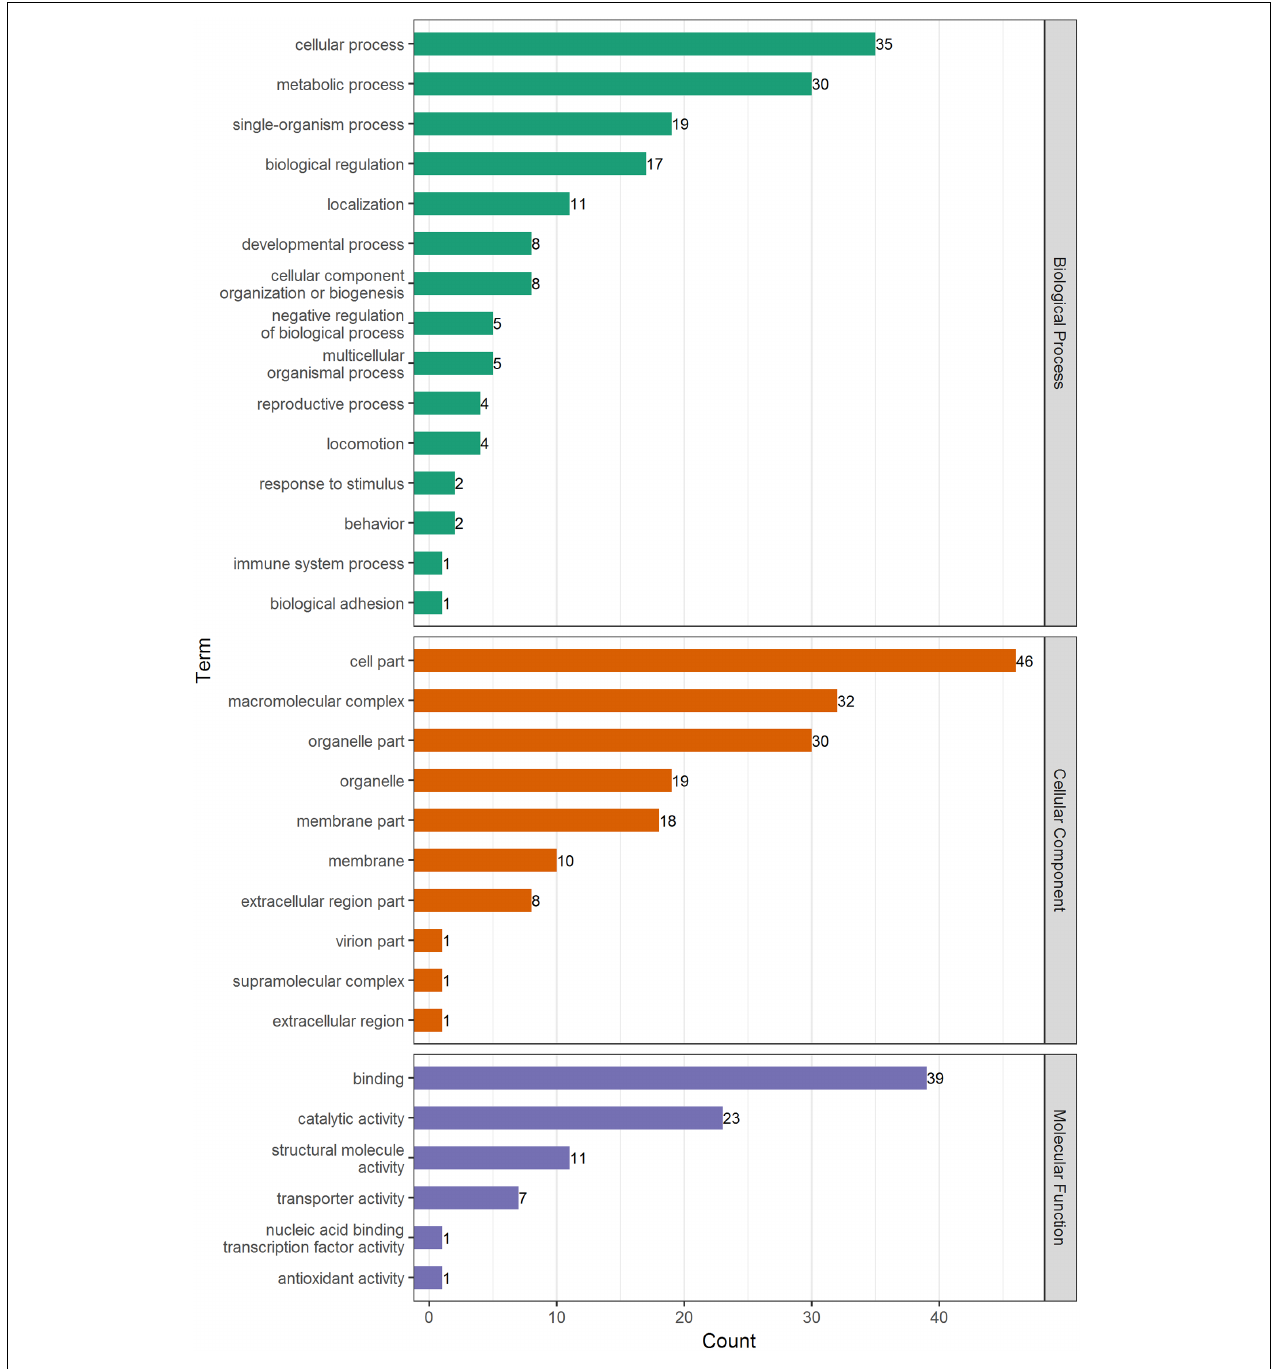
FIGURE 3 | GO analysis of DEPs in adult schistosome from water buffalo and yellow cattle. Proteins were classified into three main categories: biological process, cellular component, and molecular function.